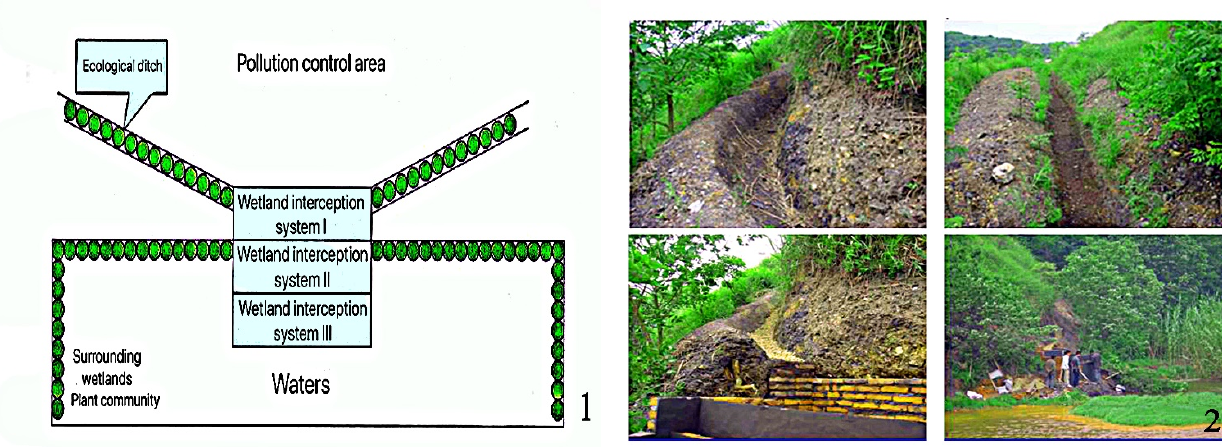
Figure 5. Ecological interception and restoration system. ( 1 ). Engineering Schematic Drawing. ( 2 ). Engineering Site of the Ecological Interception Zone.